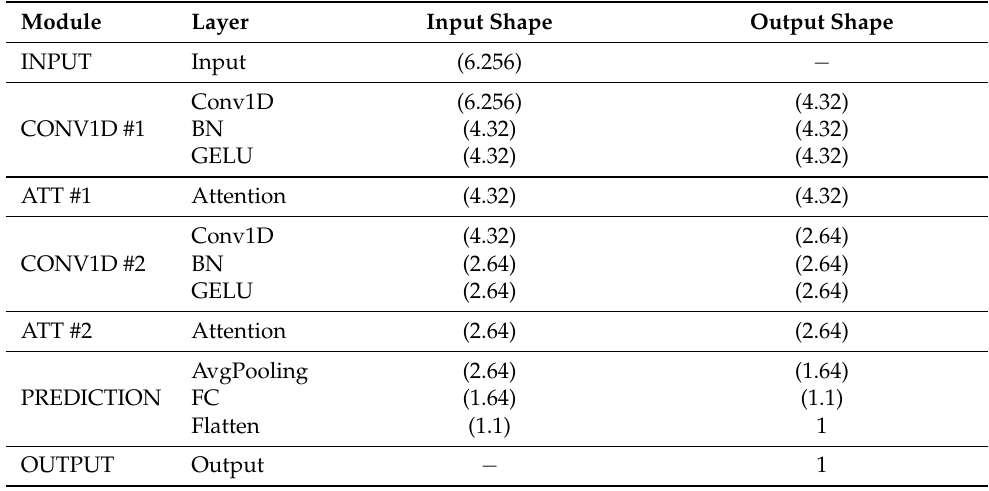
Table 3. The structure of the proposed network. The dimensions of the input and the output feature map of each layer are